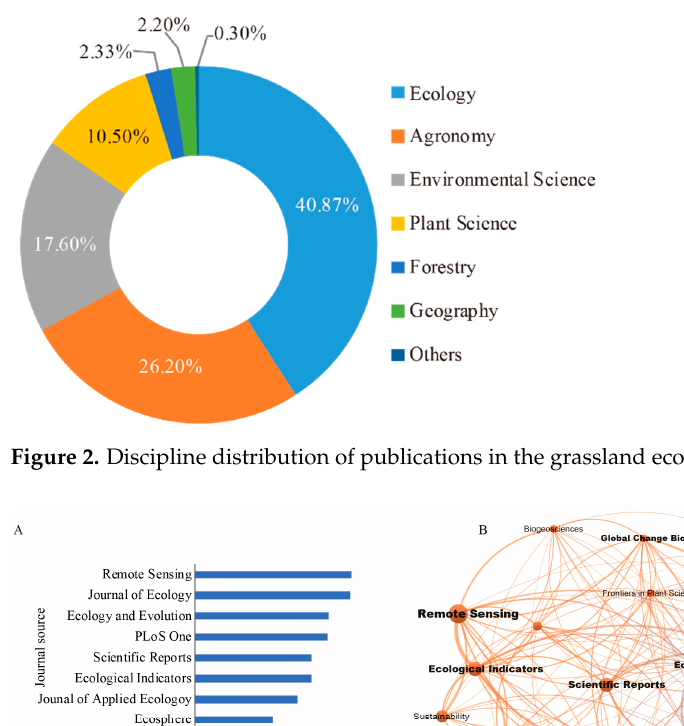
Figure 1. Cumulative number and annual growth rate of publications in the grassland ecosystem field from the Web of Science database (1990—2021).